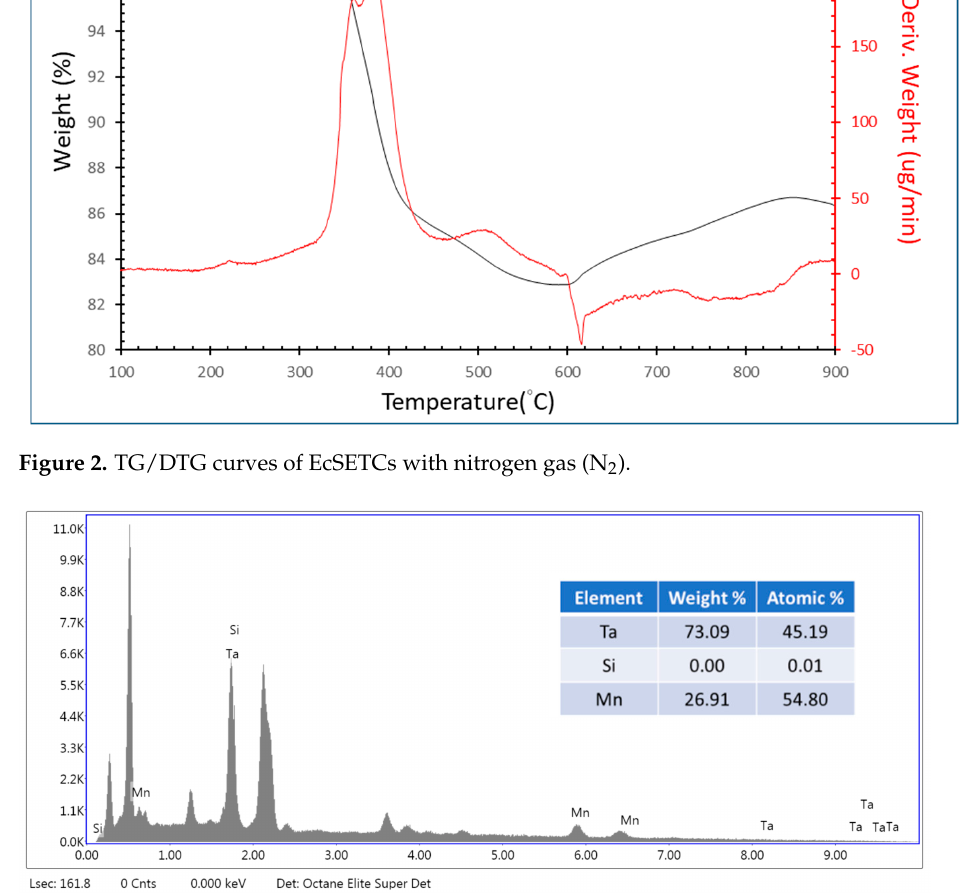
Figure 3. ( a ) The SEM-EDS patterns of the samples after pyrolysis, grinding, washing, and crushing and the quantitative analysis of samples by SEM-EDS.